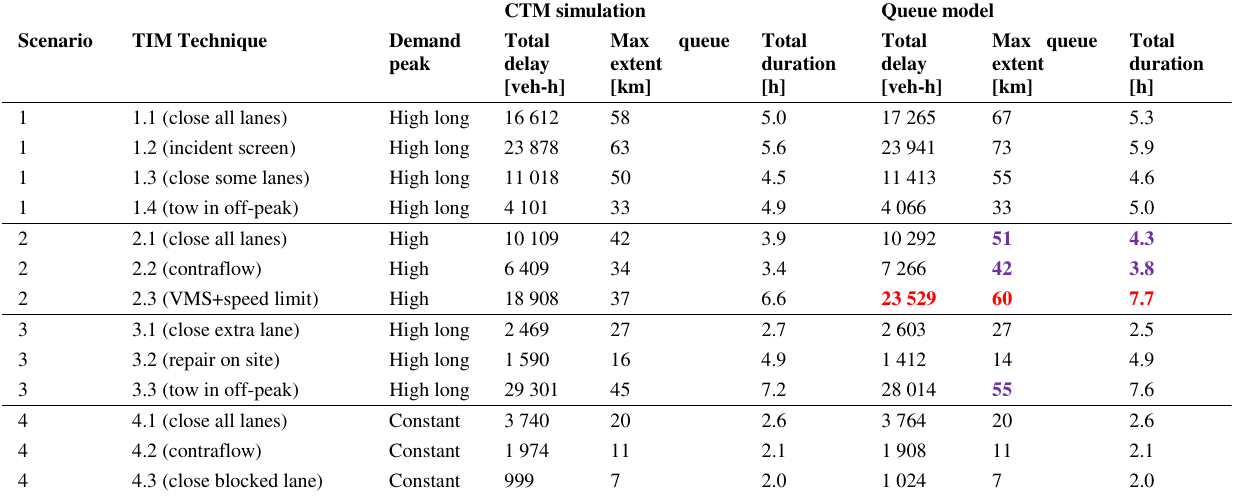
Comparing results simulated by CTM-v and queue model aggregated for all sub-cases of Scenario and Technique with one level of demand for each, comparing only congested locations upstream of the incident (the largest differences are highlighted) CTM simulation Queue model